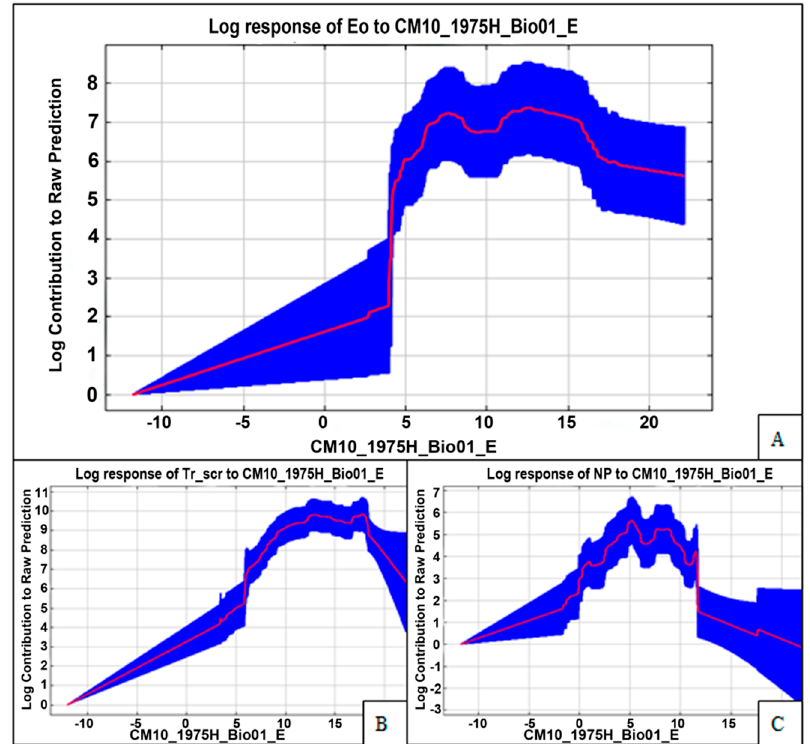
Figure 1. Maxent model created using only the variable bio1 (annual mean temperature (°C, CliMond)) from: ( A ) E. orbicularis ; ( B ) T. scripta ; ( C ) N. procyonoides